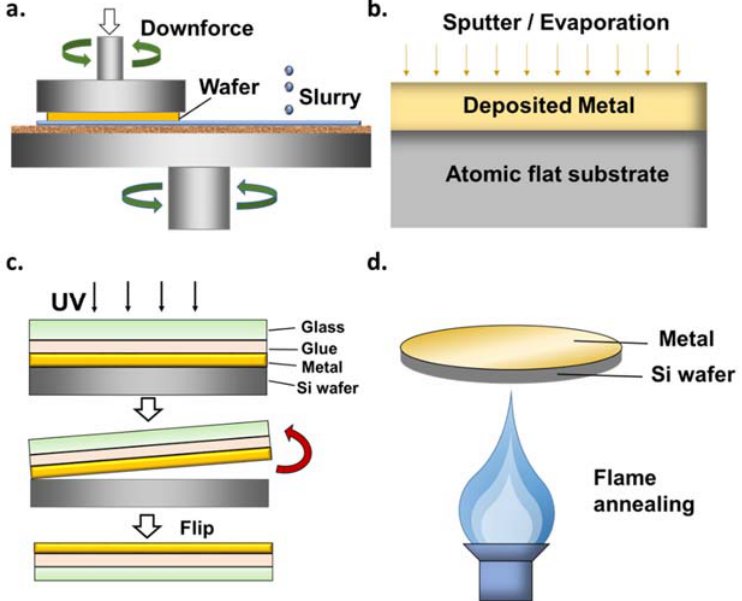
Figure 6. Schematic illustration of four different substrate preparation processes ( a ) chemical mechanical polishing; ( b ) PVD; ( c ) template stripping; ( d ) annealing-assisted template